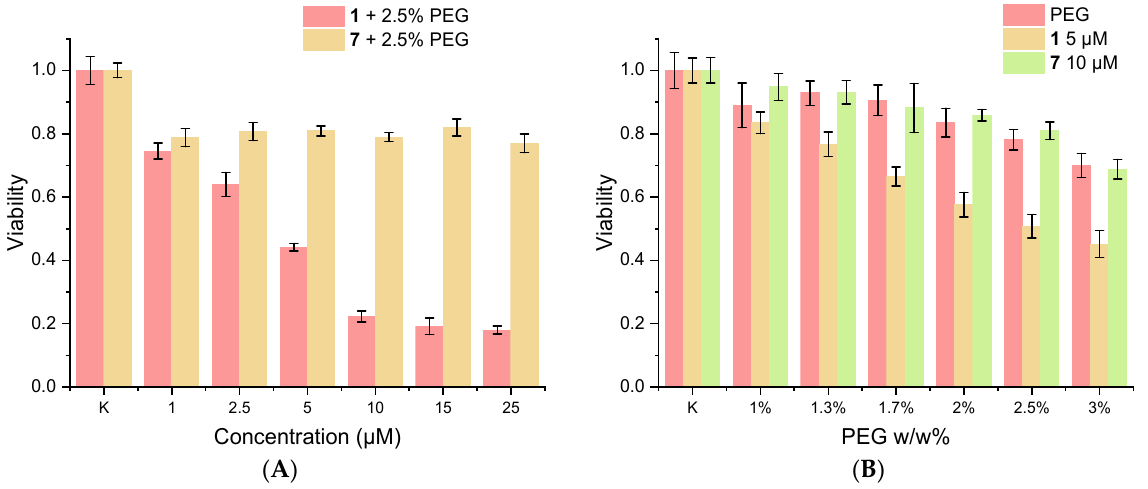
Figure 5. MTT assay of CHO-K1 cells after incubation with 1 and 7 in DMEM/FBS/PEG-200 media: ( A ) at different concentrations of the complexes and constant PEG-200 content 2.5%; ( B ) at different PEG-200 content and 1 and 7 concentrations of 5.0 and 10.0, respectively, 37 °C, 24 h. Cell viability of control cells (without probe and PEG-200) was taken for 1. Black bars show standard deviation. N = 12 repetitions.